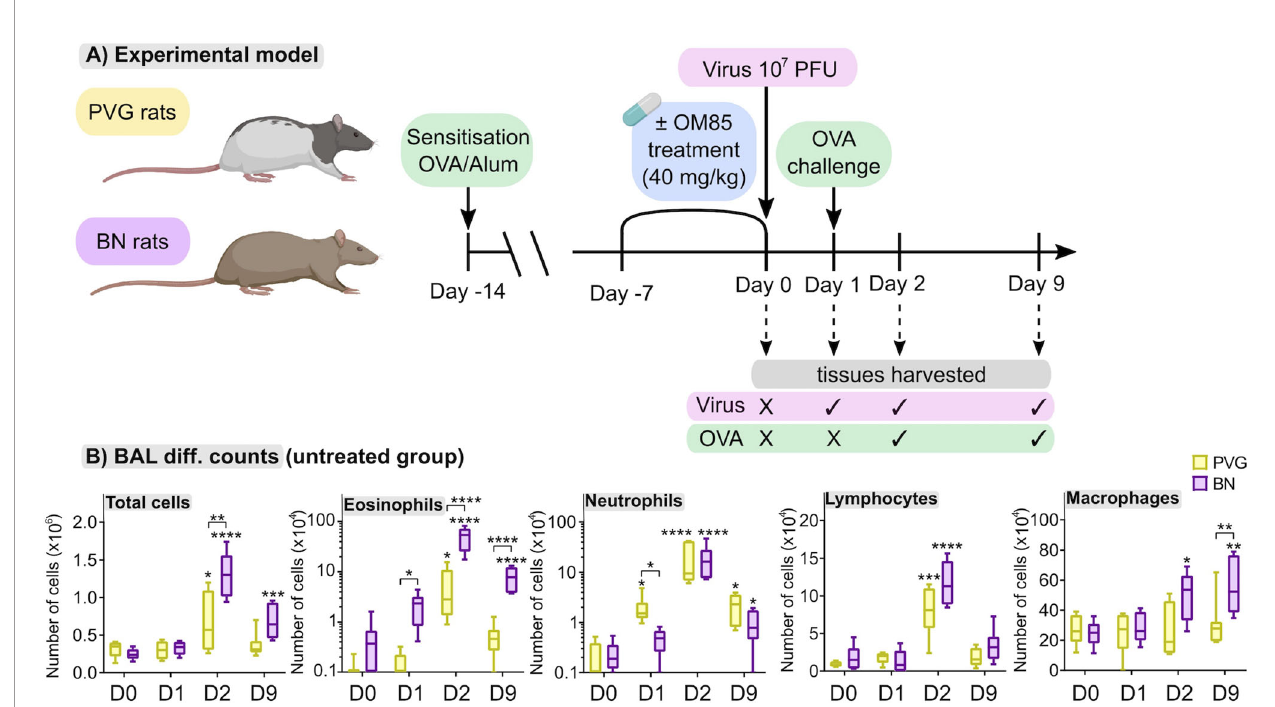
FIGURE 1 | PVG and BN rats exhibit distinct cellular pro fi les of airways in fl ammation following virus/allergen coexposure. (A) PVG and BN rats were sensitized with OVA/Alum. Seven days later, rats from each strain were randomly allocated to experimental groups receiving OM-85 for seven consecutive days or nil treatment. All animals apart from a baseline control group (Day 0) were then infected with attenuated mengovirus and challenged with OVA 24hr later. Tissues were harvested at baseline, one day post-infection representing the response to virus alone, and days two and nine post-infection representing the response to virus and allergen co- exposure. The analyses performed included i) differential cell counts on BAL fl uid, ii) RNA-Seq on homogenized lung and bone marrow, iii) 14-colour fl ow cytometry on single-cell suspensions of PBMC, airway draining lymph node, bone marrow and peripheral lung tissue, and iv) assessment of the gut microbiome (prior to virus/ allergen coexposure only). Figure created with BioRender.com (B) Enumeration of total cells, eosinophils, neutrophils, lymphocytes, and macrophages in BAL via differential cell counts at baseline and following viral/OVA challenge in PVG and BN rats without OM-85 treatment. Data from more than 3 independent experiments, n = 6 – 8 per group. Two-way ANOVA with Tukey ’ s multiple comparisons test were performed to compare data within and between strains. *p < 0.05, **p < 0.01, ***p < 0.001, and ****p < 0.0001. BAL, bronchoalveolar lavage, D0: day 0, D1: day 1, D2: day 2, D9: day